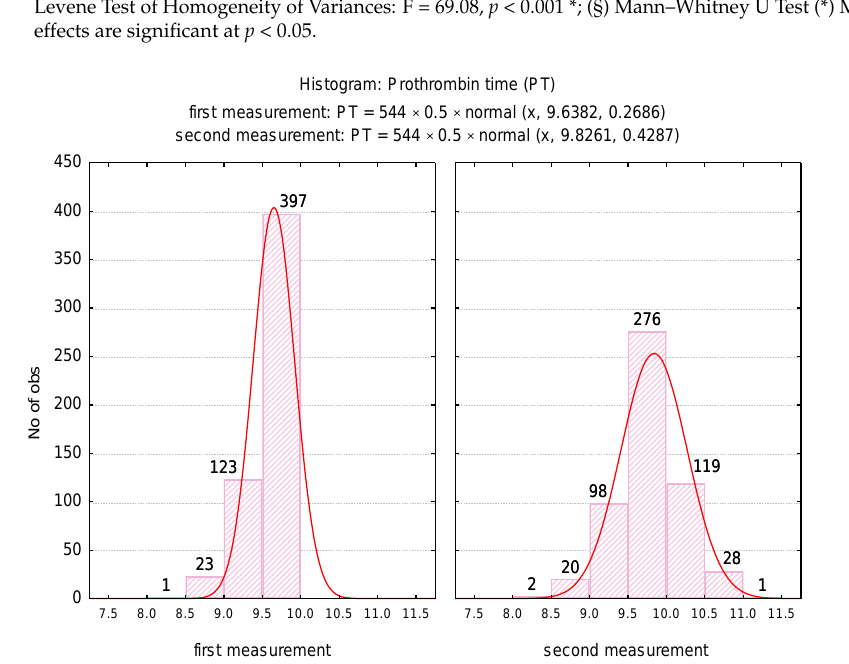
Figure 1. Histogram of PT values depending on the time of determination.